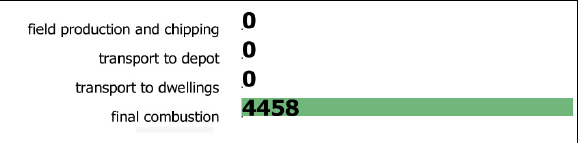
Figure 14. Amount of renewable primary energy associated with the nodes practice concerning the use of the local poplar woodchips for housing heating, MJ / person * year (Magentino- Abbiatense context).